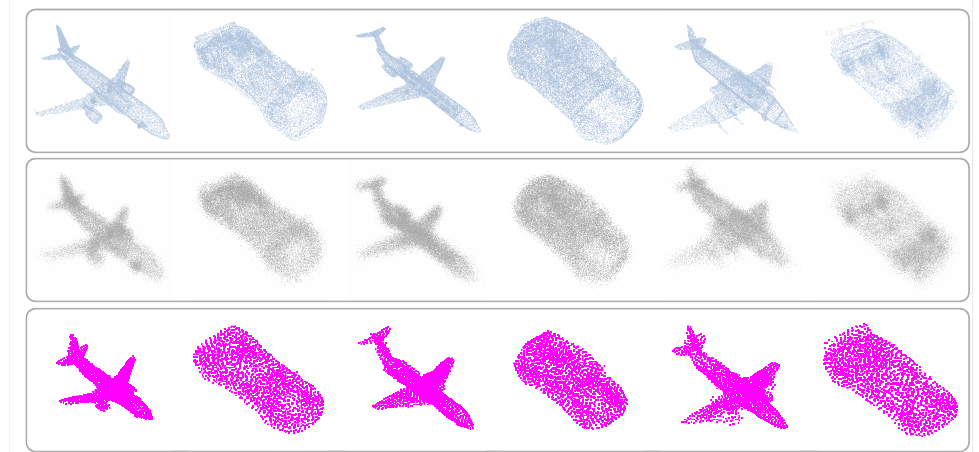
Figure 5. Sample results from experiments on GPD-Net dataset: instances in the first row are of ground truth canonical point clouds, the second row shows inputs to be denoised in the testing stage ( σ = 0.02), the third row shows the outputs of our